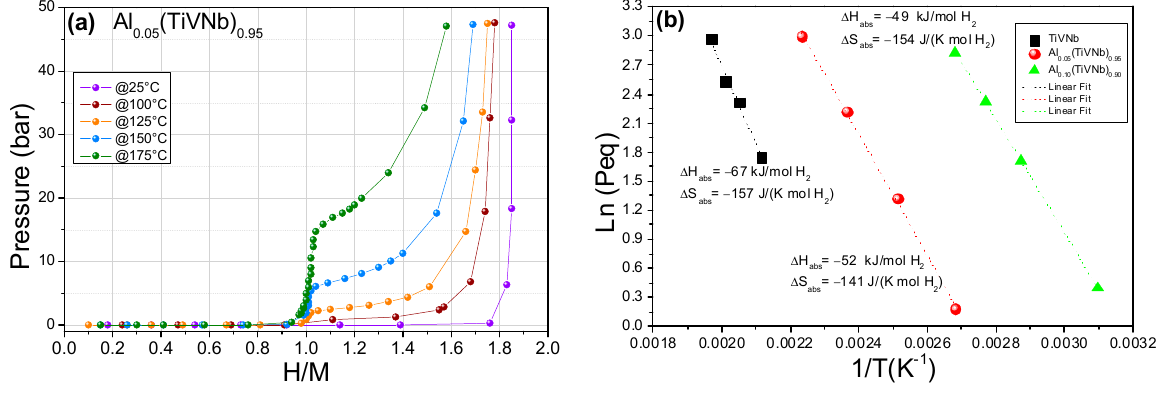
Figure 4. ( a ) PCIs for Al 0.05 (TiVNb) 0.95 in the temperature range 25–175 °C, ( b ) Van’t Hoff plots for Al x (TiVNb) 1 − x (x = 0 [17], 0.05, 0.10 [17]). Table 4. Thermodynamic properties of hydride formation in Al 0.05 (TiVNb) 0.95 together with already reported experimental and ML predicted values for TiVNb and Al 0.10 (TiVNb) 0.90 [17]. Composition